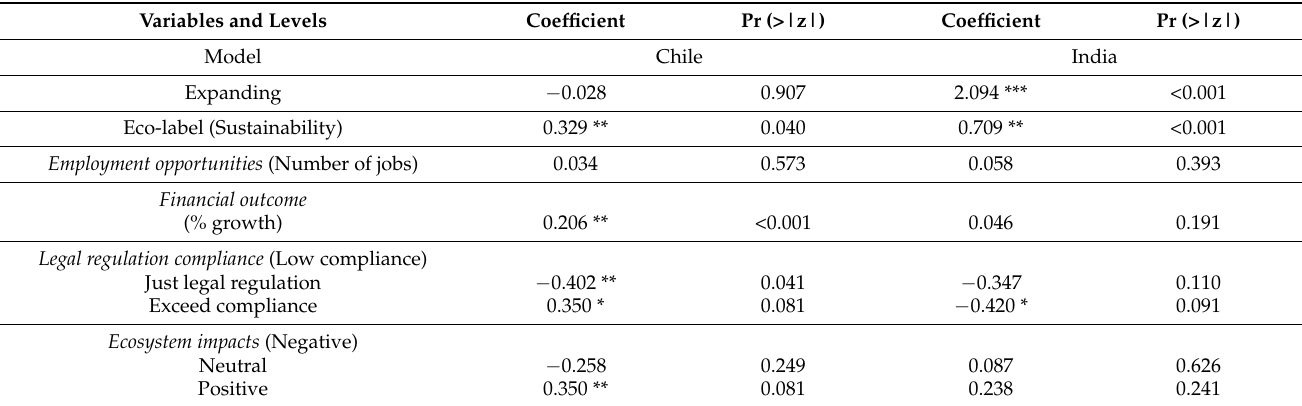
Table 4. RPL Models by